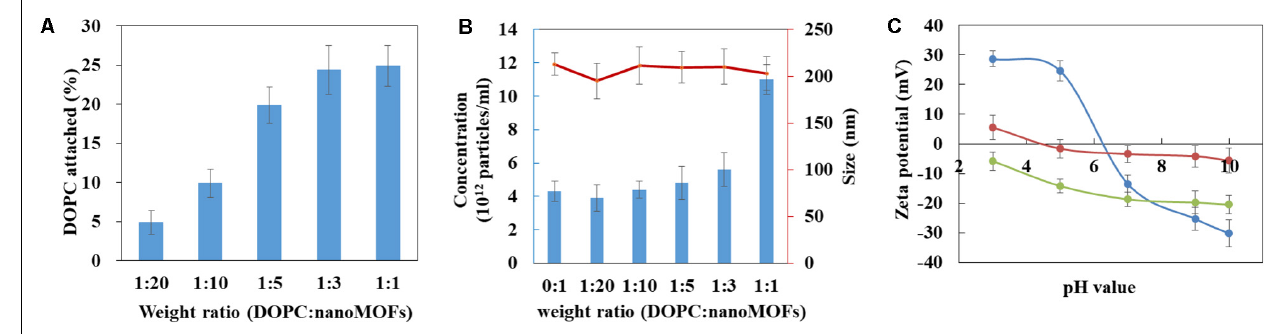
FIGURE 3 | Characterization of lipid-coated nanoMOFs. (A) Quantification of the amount of DOPC in the nanoMOFs; (B) Mean hydrodynamic diameter (red) and concentration (blue) of DOPC-coated nanoMOFs determined by NTA. (C) Zeta potential of nanoMOFs as a function of pH before (blue) and after lipid coating with (red) or without (green) the addition of DSPE-PEG